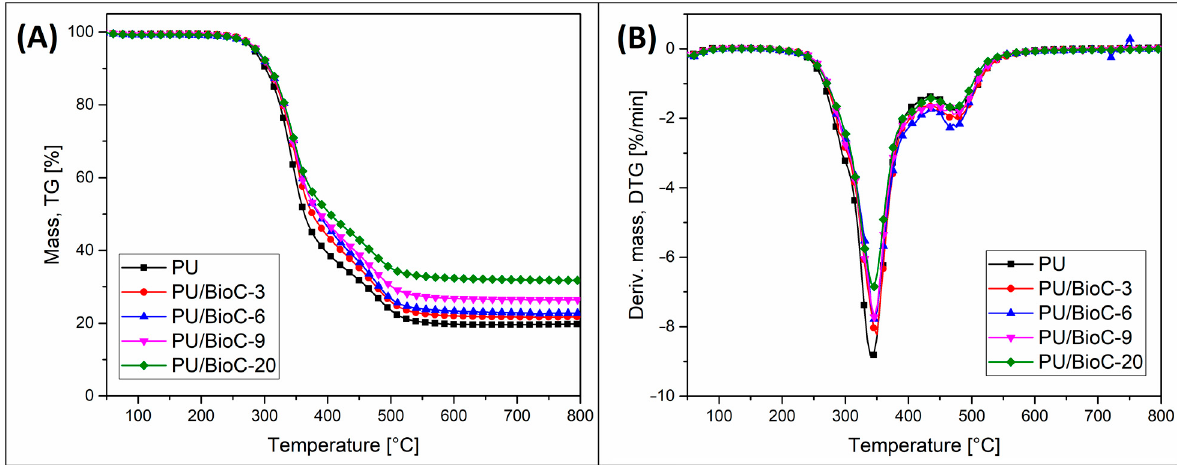
Figure 7. Results of thermogravimetric measurements performed under nitrogen atmosphere. ( A ) TG mass loss plots and ( B ) DTG derivative mass loss plots. Table 5. Results of TG and DTG plots analysis.